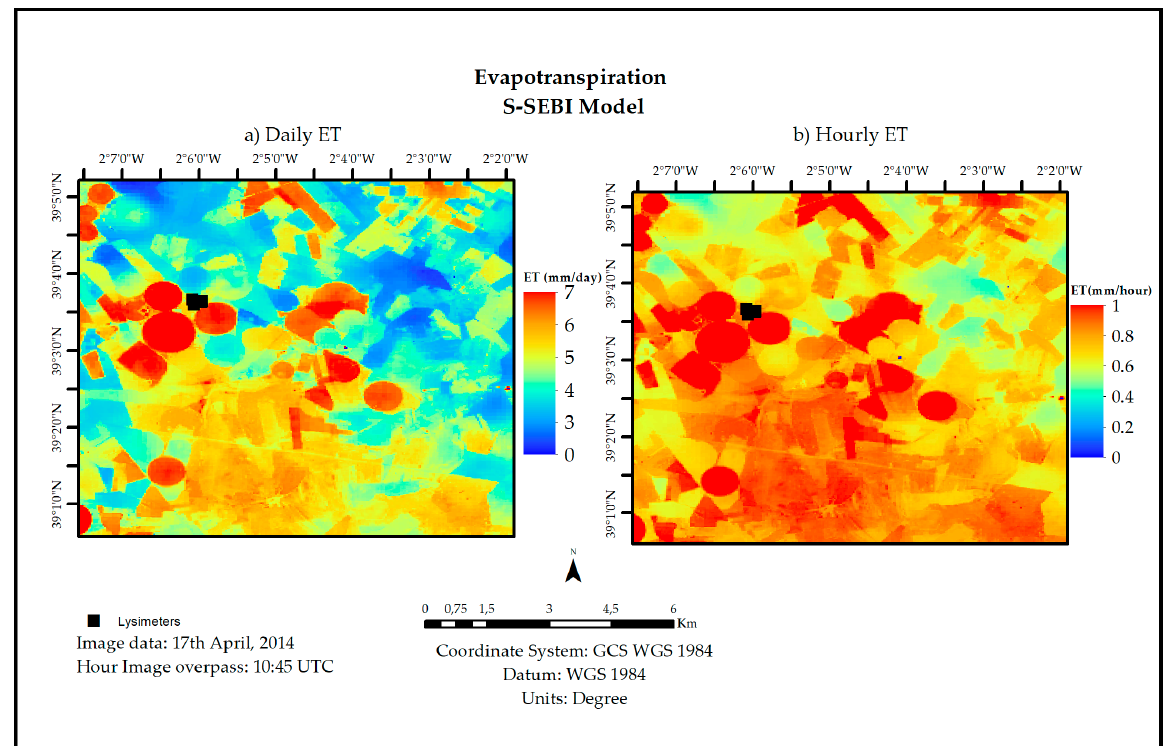
Figure 7. Spatial distribution of ( a ) daily (mm/day) and ( b ) hourly (mm/h) ET obtained by the S-SEBI model over Barrax site on 17 April 2014.